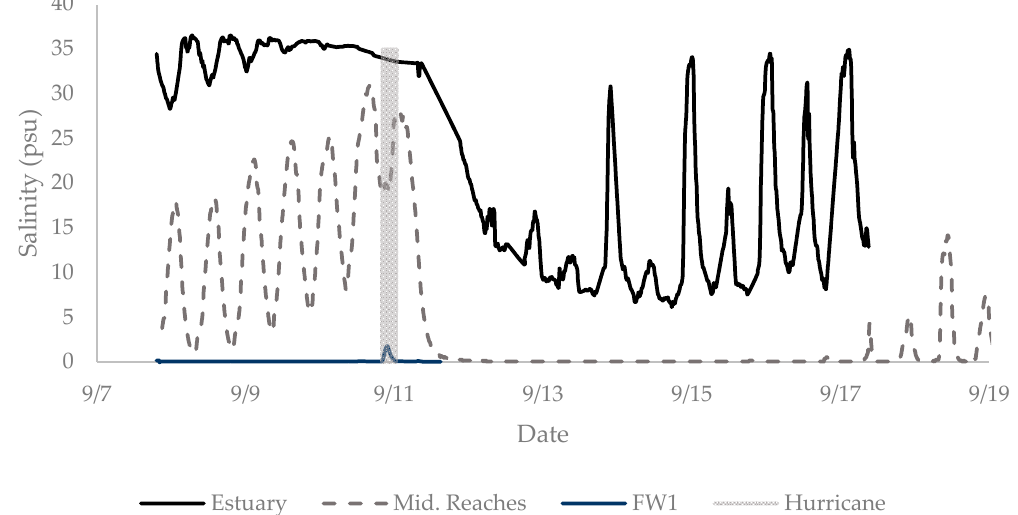
Figure 3. Salinity graph showing fluctuations at the three sonde locations for before, during, and after Hurricane Irma. Salinity values within the estuary (black line), middle reaches (dashed grey line), and freshwater 1 (solid grey line) 2 days before Irma, during the storm (grey bar), and 1 week after the hurricane had passed.